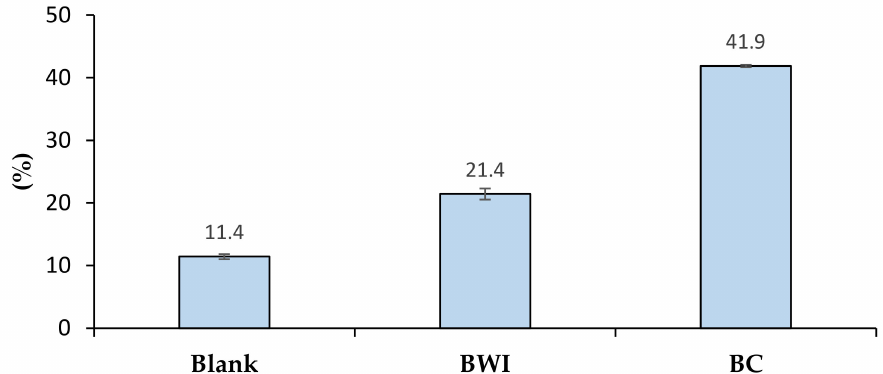
Figure 6. Mean volume reduction for all storm events and salt concentration for each column type. Error bars indicate standard error of duplicate measurements (blank: no plants; BWI: Blue Wild Indigo; BC: Broadleaf Cattail).